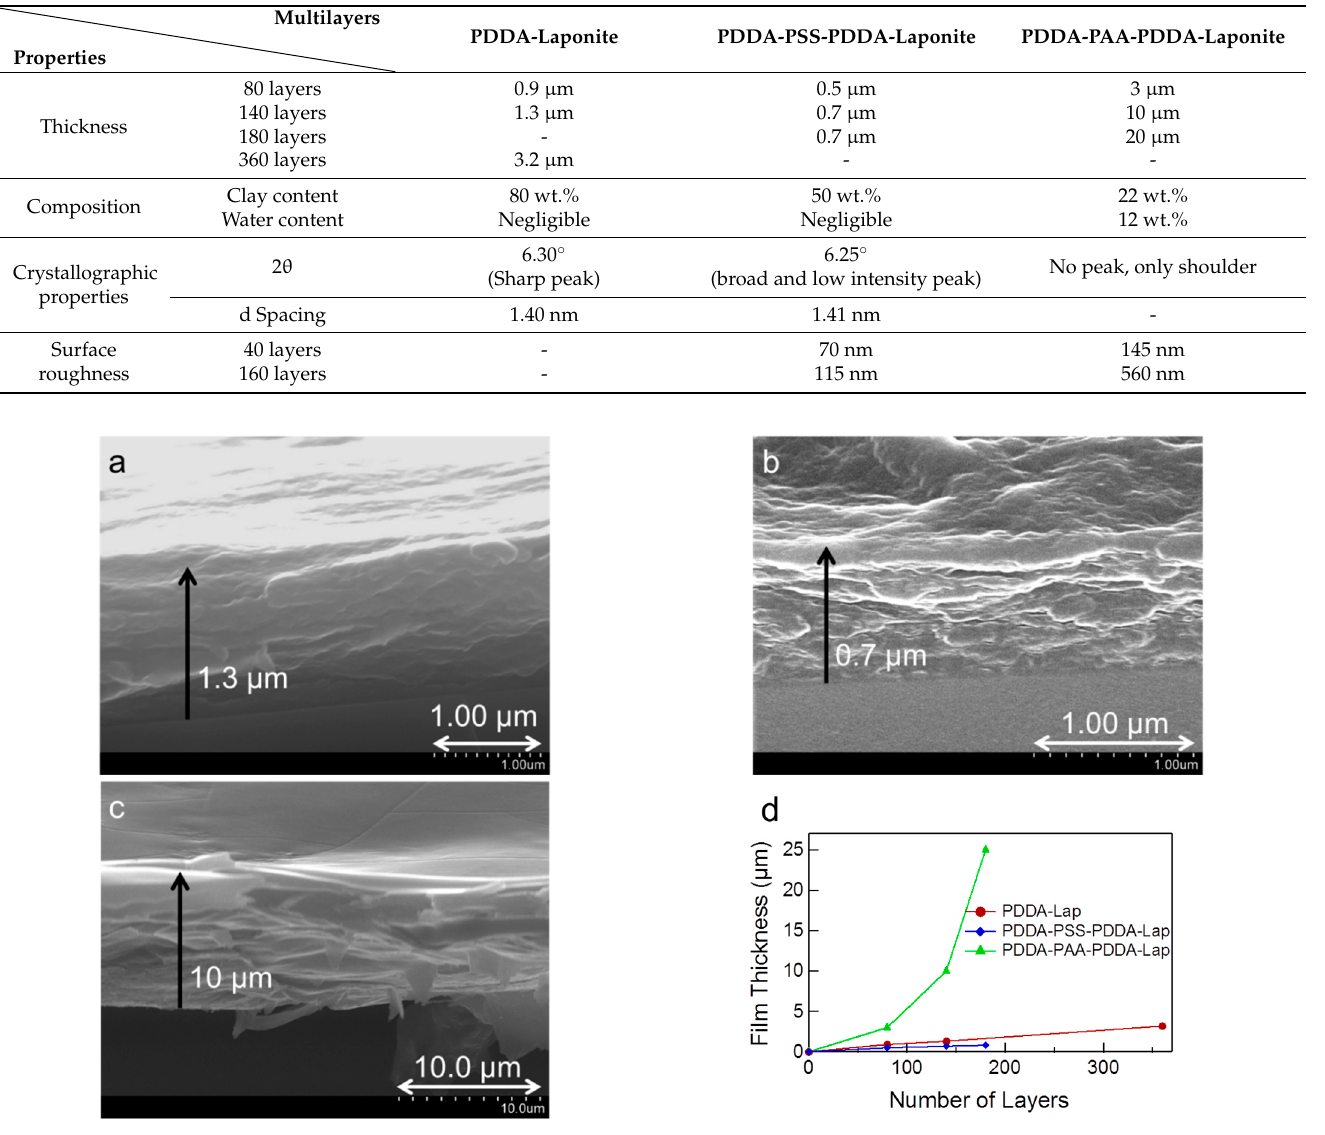
Figure 1. SEM cross-section images of 140-layer films of ( a ) PDDA-Laponite, ( b ) PDDA-PSS-PDDA- Laponite, and ( c ) PDDA-PAA-PDDA-Laponite. Lines with arrows indicate the thickness of the film deposited on the substrate. ( d ) Film thickness as a function of the number of layers for the three systems.